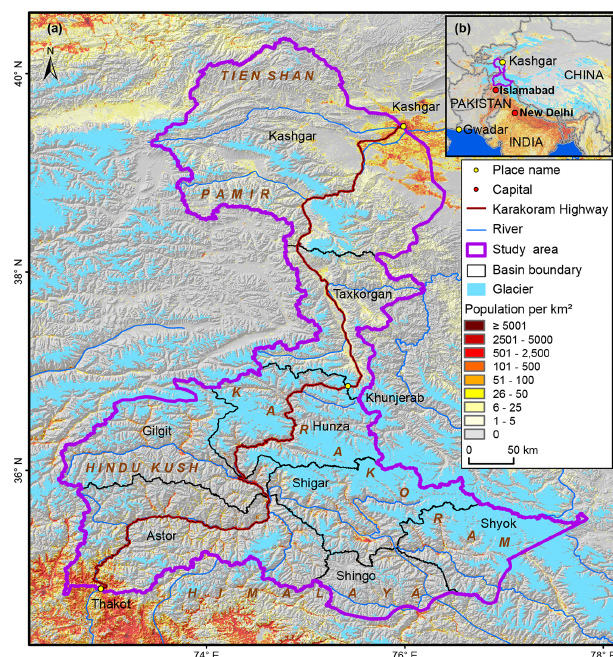
Figure 1. Location of the study area associated with the distribution of glaciers (RGI Consortium, 2017), mountains, basins, and popu- lation (Rose et al., 2021) (a) , and its location within the CPEC (b)